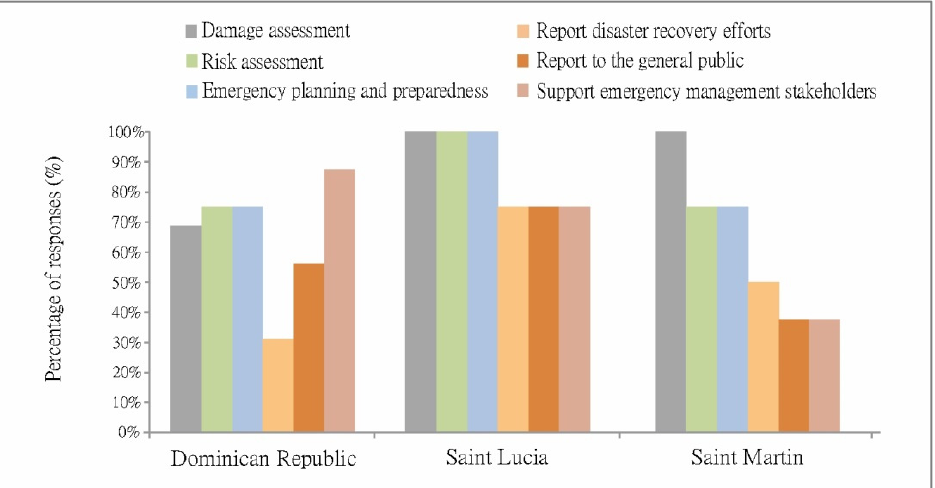
Figure 11. Main purposes of EMT maps (Q32).